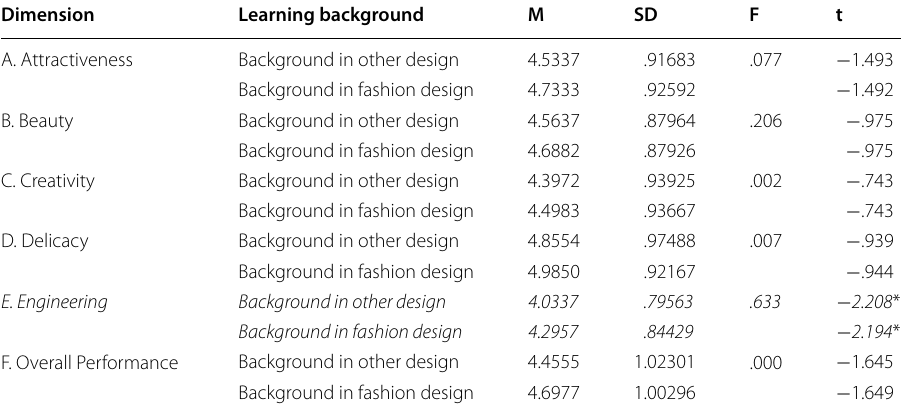
Table 5 T test of dimensions of the questionnaire of different learning background (N 192) =